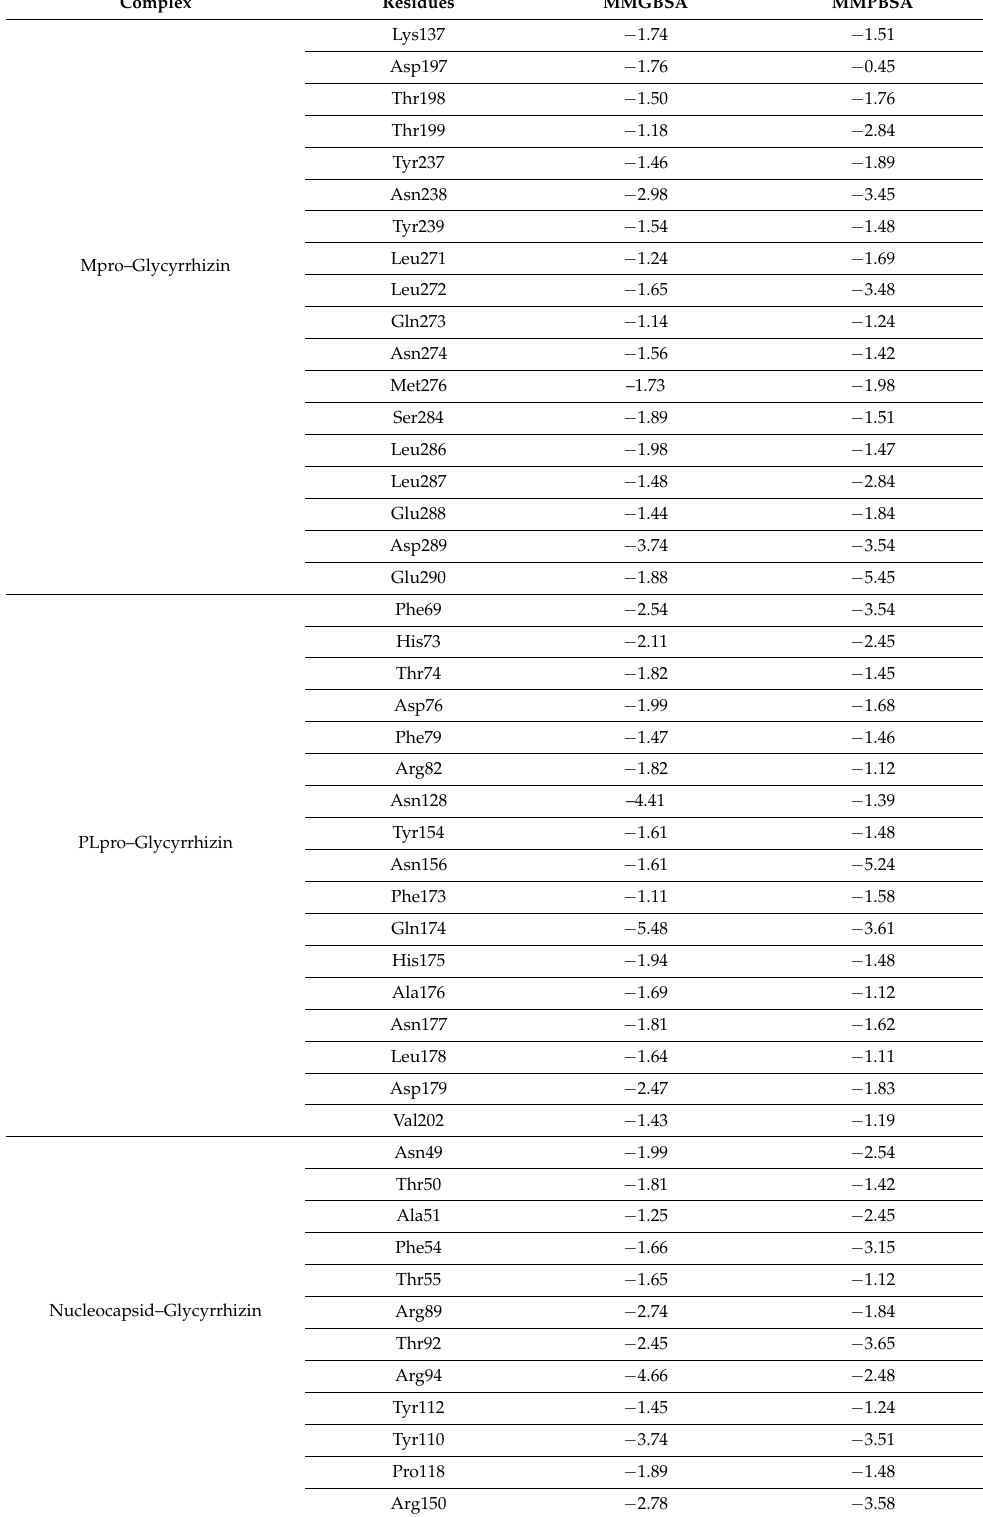
Table 2. Hotspot residues identified that played a significant role in interaction with the glycyrrhizin.